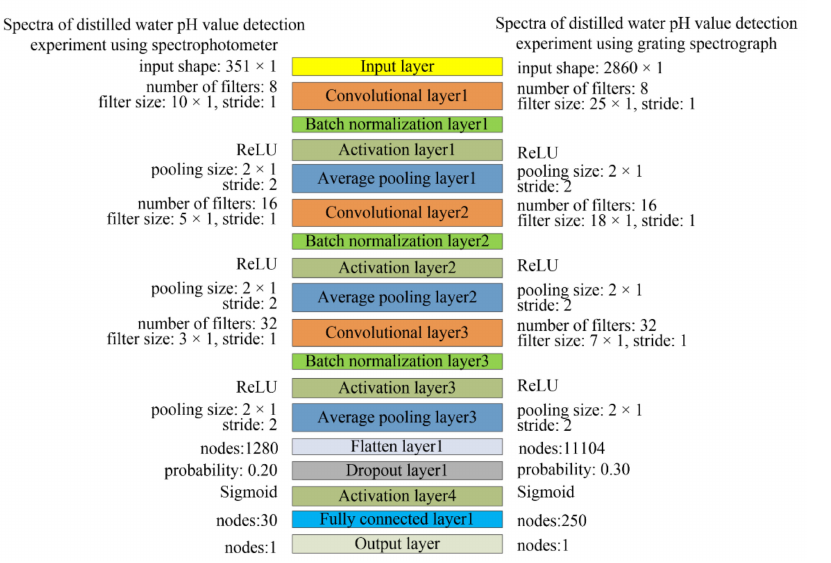
Figure 2. Architecture of 1D-CNN